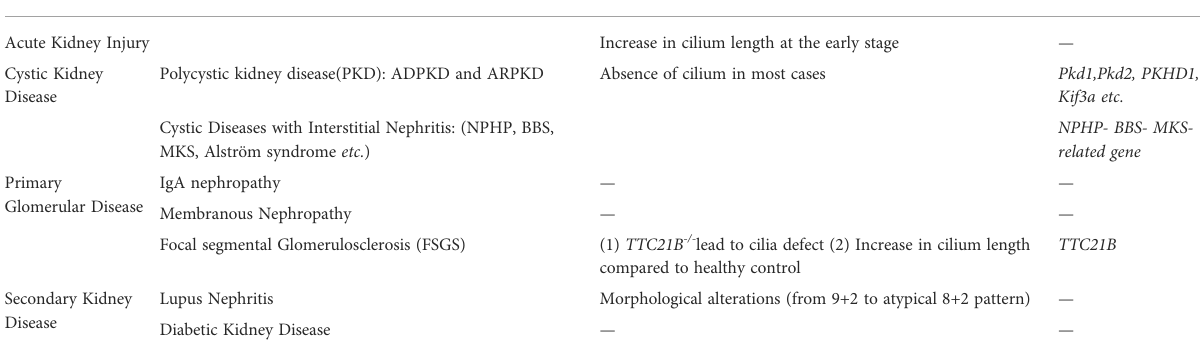
TABLE 1 Cilia phenotype in kidney